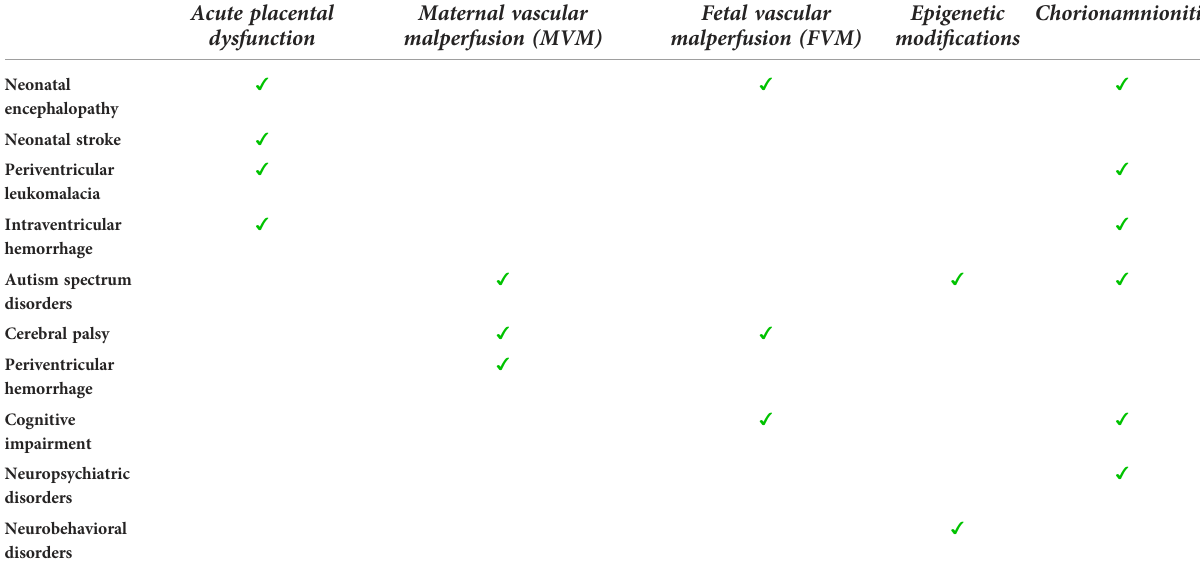
TABLE 2 Correlations between selected placental lesions and fetal neurological